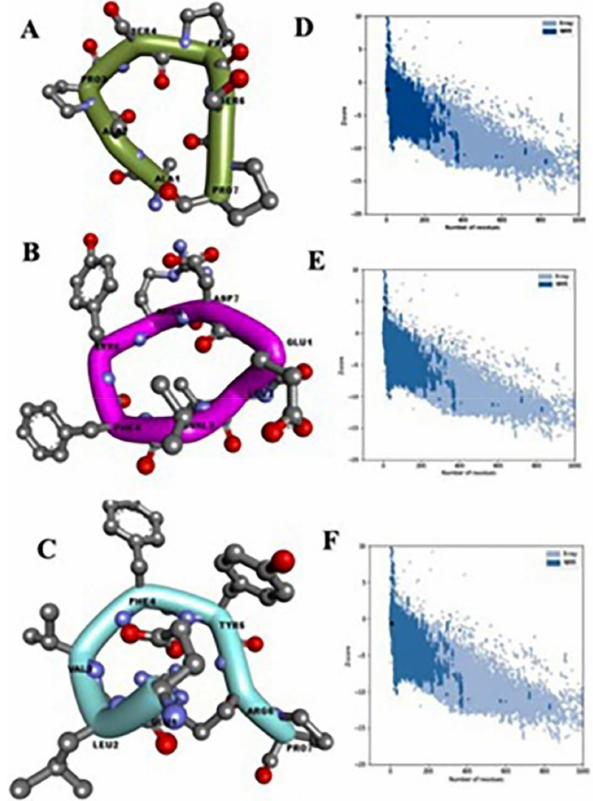
Figure 4. Predicted peptide 3D-structure homology models. ( A ) SA626, ( B ), SA923, and ( C ) SA905 and their corresponding ProSA z _ score plots ( D – F